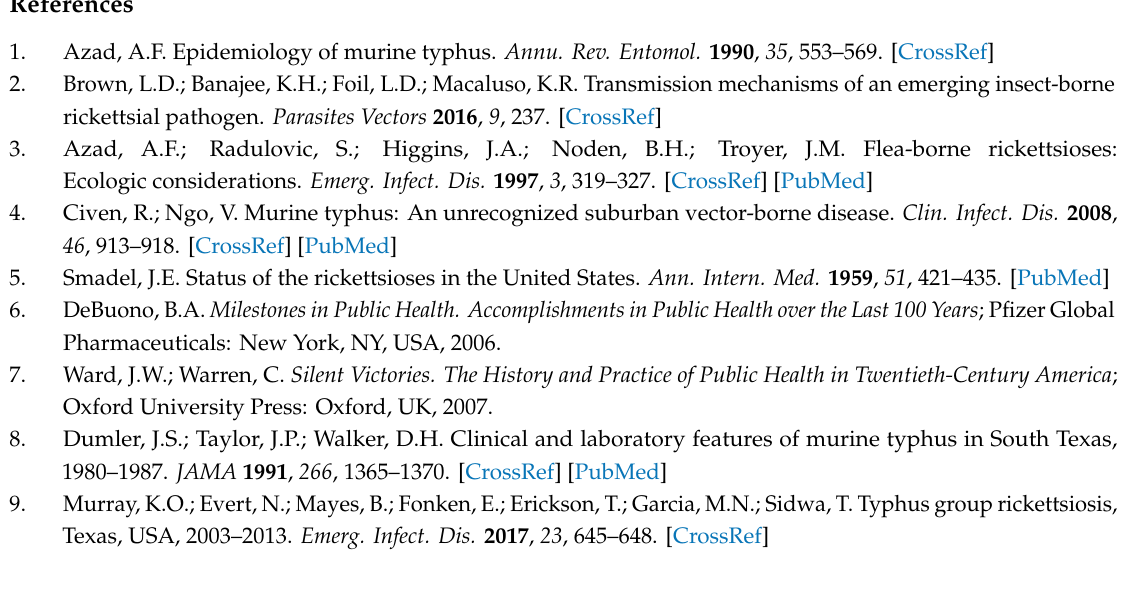
Image Credits: Figure 1R, Figure 2, Figure 3R, Figure 8L, Figure 9: National Library of Medicine; Figure 2L, Fund of the Royal Academy of Medicine of Catalonia; Figure 4U: Texas Dept of Health; Figure 4L: Alabama Department of Archives and History; Figure 5, Figure 6, Figure 7: Louisiana Division. New Orleans Public Library; Figure 10: South Carolina Department of Health and Environmental